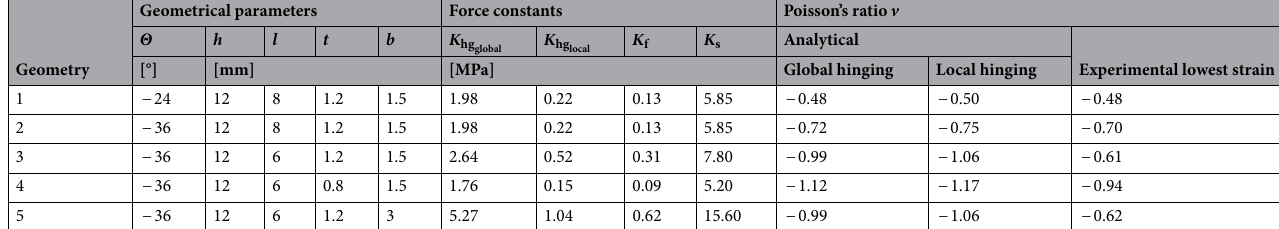
Table 1. Geometrical parameters, force constants, and values of the Poisson’s ratio ν from the analytical